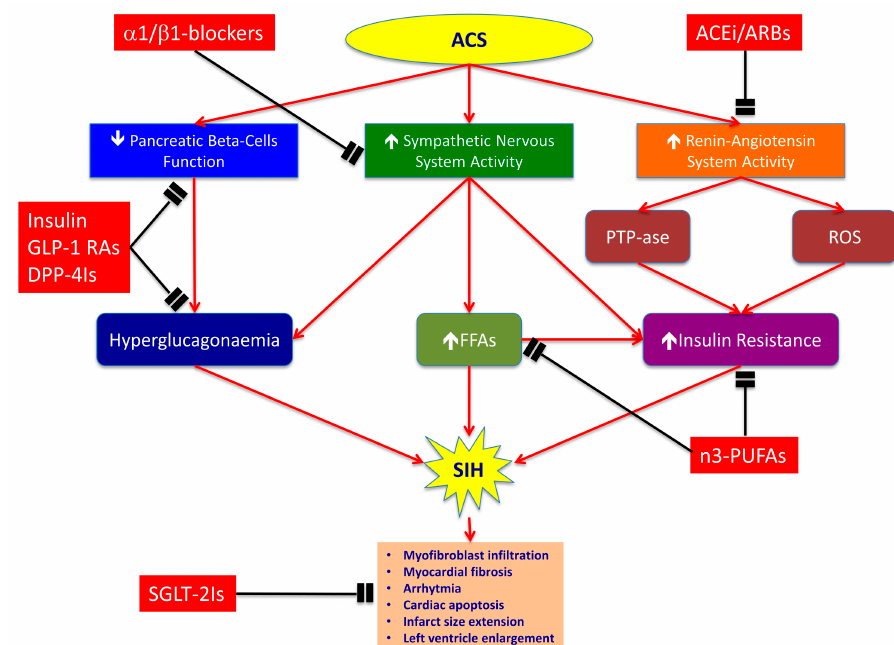
Figure 1. Mechanisms of stress-induced hyperglycaemia (SIH) during acute coronary syndrome (ACS) and comple- mentary effects of each pharmacological class. ACS determines SIH by decreasing insulin release through pancreatic beta-cells dysfunction, and by inducing insulin resistance (IR) through overactivation of sympathetic nervous and renin-angiotensin systems. The insulin decrease and adrenergic overdrive provoke hyperglucagonaemia and increase of free fatty acids (FFAs) plasmatic levels, thereby leading to hyperglycaemia. Contemporarily, renin–angiotensin–aldosterone system hyper-stimulation induces IR through the activation of phosphotyrosine phosphatases (PTPases) and reactive oxygen species (ROS) formation. Selective α 1/ β 1-blockers, such as nebivolol, antagonize adrenergic overdrive and have vasodilatory properties that are mediated by stimulation of nitric oxide (NO) release from endothelial cells. ACE inhibitors (ACEi) and an- giotensin receptor blockers (ARBs) inhibit PTPases activity and ROS formation, thereby reducing IR. The n3-polyunsaturated fatty acids (n3-PUFAs) improve cholesterol levels and insulin sensitivity compared to diets high in saturated fats. Dipeptidyl peptidase-4 inhibitors (DPP-4Is) and glucagon-like peptide-1 receptor agonists (GLP-1 RAs) improve pancreatic beta-cells function and reduce glucagon release by alfa-cells, thereby lowering HbA1c levels. Finally, sodium-glucose co-transporters 2 inhibitors (SGLT-2Is) have cardiovascular benefits mostly unrelated to the extent of glucose lowering. They could involve effects on haemodynamic parameters, such as reduced plasma volume, and direct effects on cardiac metabolism and func- tion, such as myocardial fibrosis, cardiac apoptosis and infarct size enlargement. Red lines indicate activation pathways; black lines indicate inhibition pathways; ↑ indicates an increase; ↓ indicates a decrease.